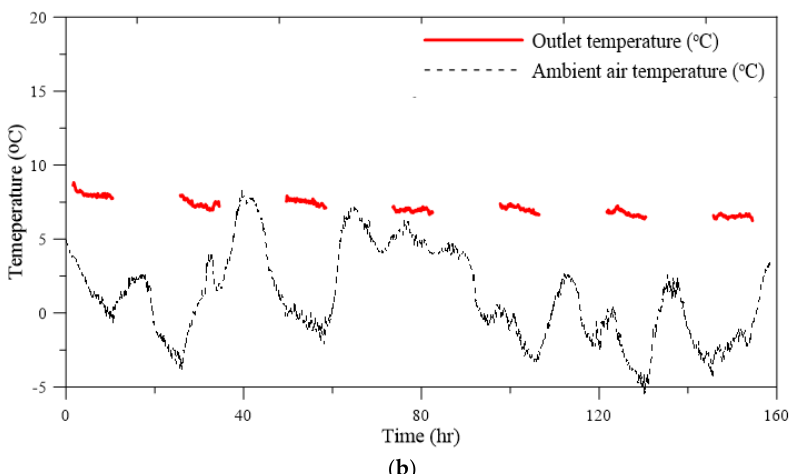
Figure 12. Thermal performance test (TPT) results of the floor-type energy slab with high-density polyethylene (HDPE) pipe (with thermally insulation). ( a ) Inlet, outlet temperature and heat exchange amount; ( b ) Outlet and ambient air temperature.